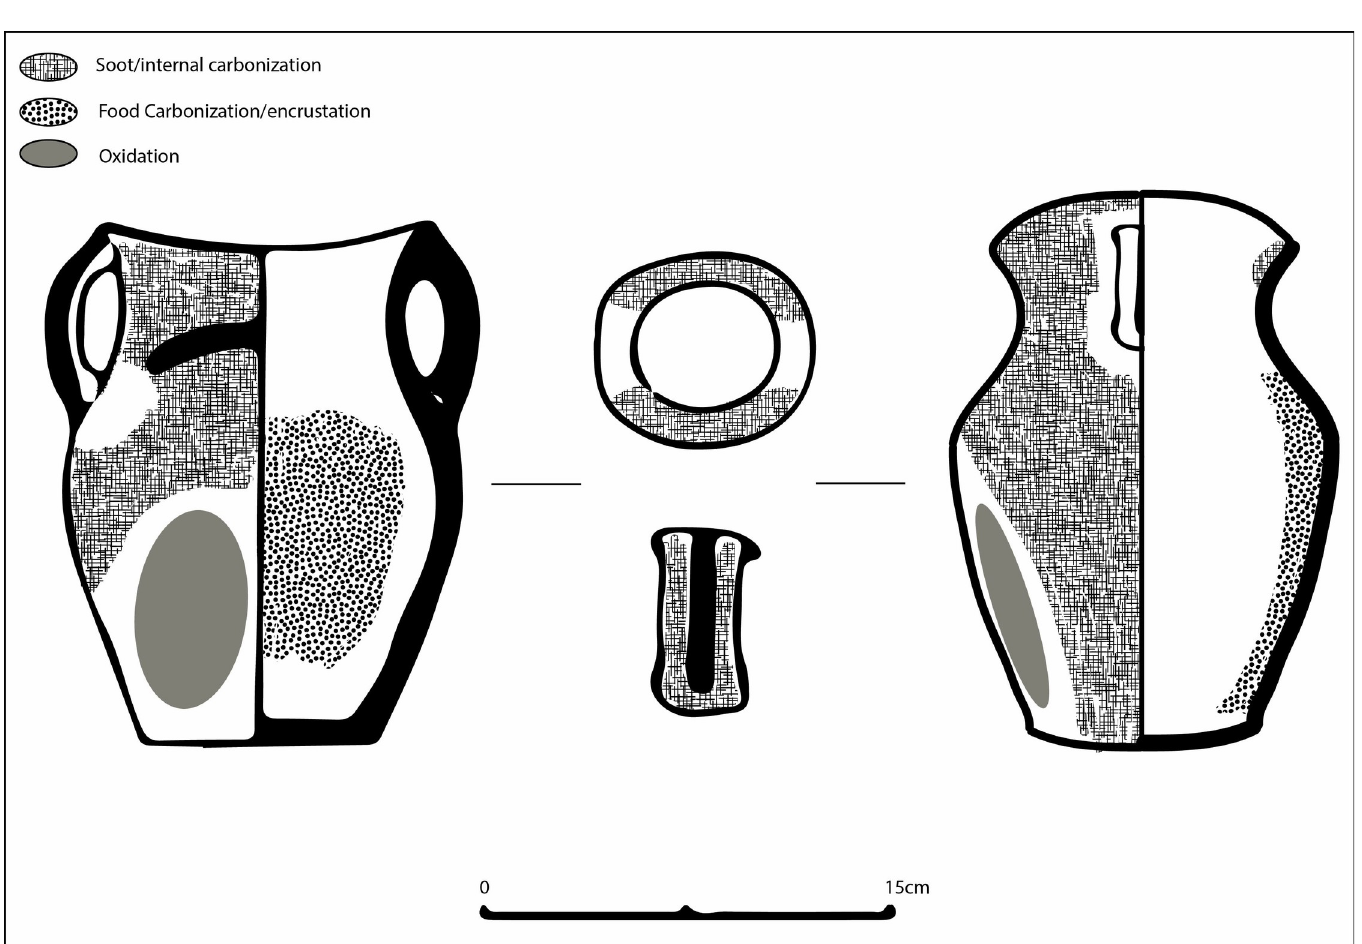
Fig 4. Schematic image of dominant use-wear pattern observed on Siwa ma’an cooking vessels.